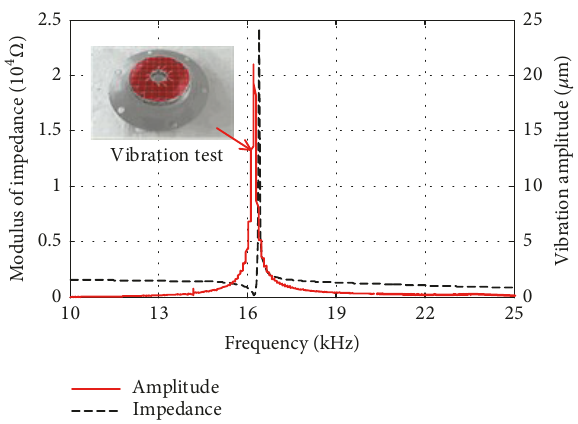
Figure 4: The theoretical result of the transducer’s impedance model and the measuring result of the vibrating amplitude at the horn’s front